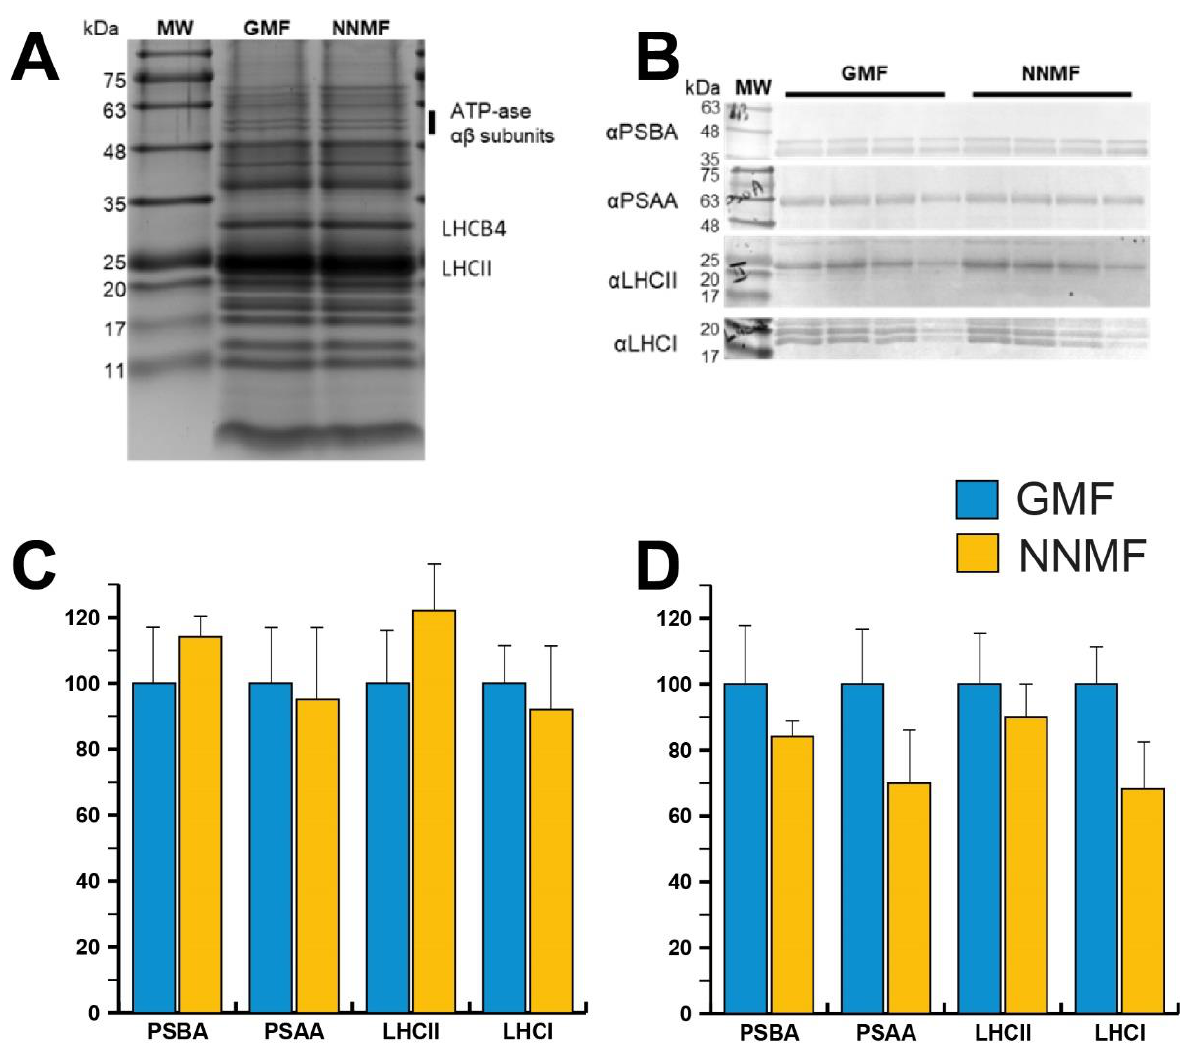
Figure 9. ( A ) SDS-PAGE analysis of protein complexes accumulated in GMF and NNMF thylakoidal membranes. Three micrograms of chlorophyll were loaded in each lane. ( B ) Immunoblotting used for the quantification of representative proteins (PSBA, PSAA, LHCII and LHCA) composing PSII or PSI in GMF and NNMF thylakoids. Loading corresponded to 2, 1.5, 1 and 0.5 µ g of chlorophyll. ( C ) Rela- tive accumulation of representative proteins indicated in ( B ), having protein accumulation in GMF samples as a reference (100%). ( D ) Relative accumulation per dry weight of representative proteins indicated in ( B ) calculated from chlorophyll content per dry weight, having protein accumulation in GMF samples as a reference